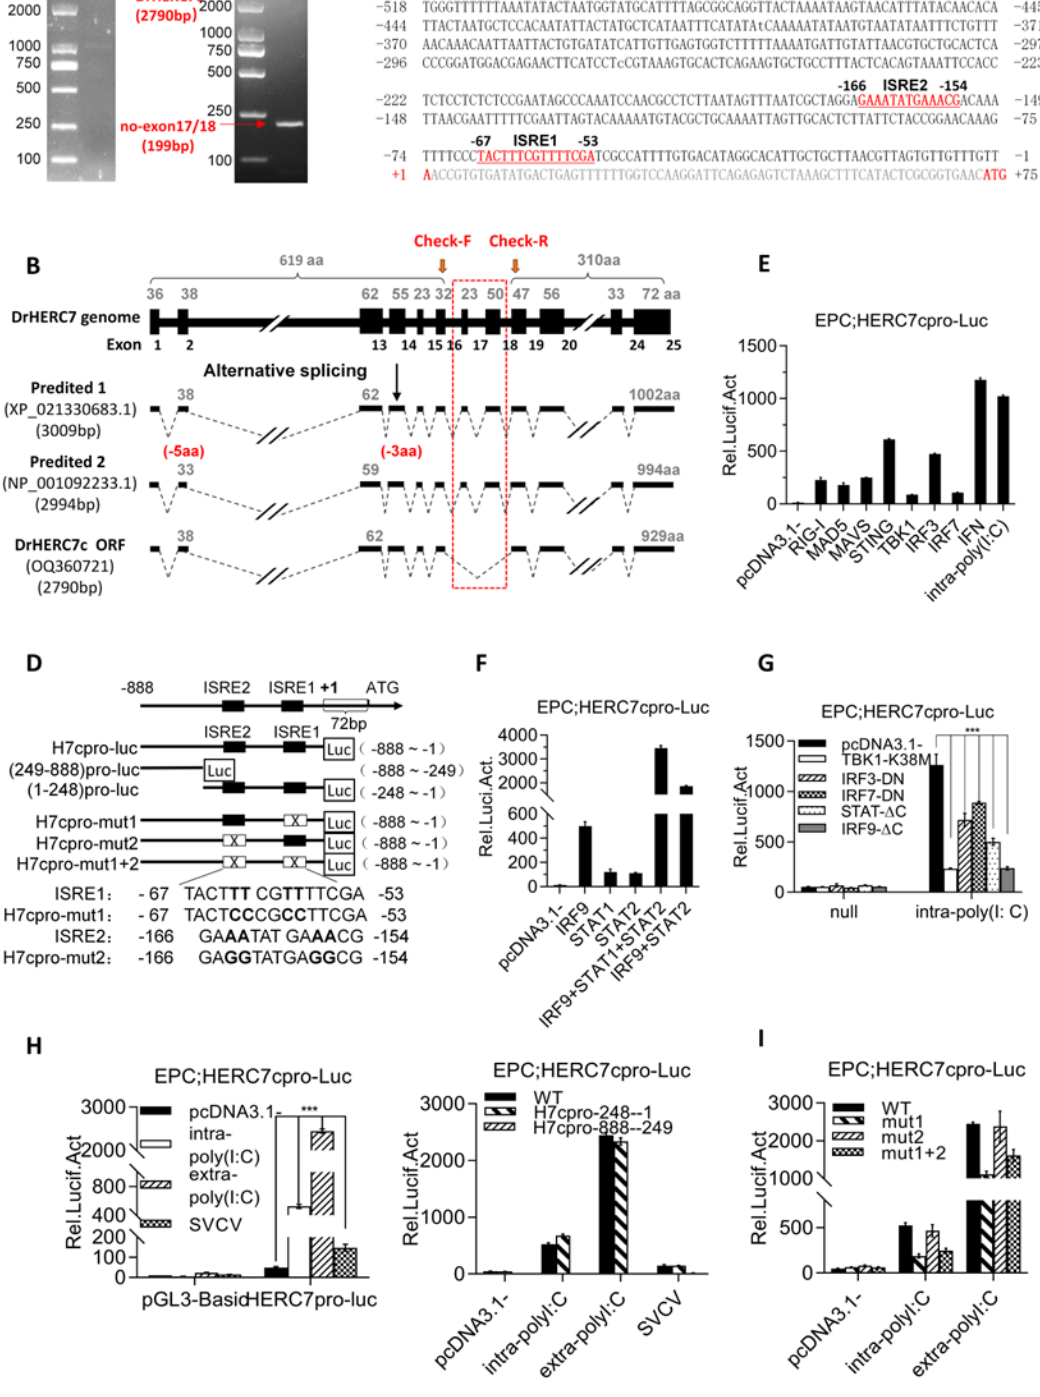
Figure 2. Zebrafish herc7c is a typical ISG. ( A ) Amplification of full-length cDNA (left) and fragment (right) of the herc7c gene. ( B ) Exon–intron structure and transcriptional splicing analysis of the zebrafish herc7c genome. The black box represents the exon. The red dotted box indicates the